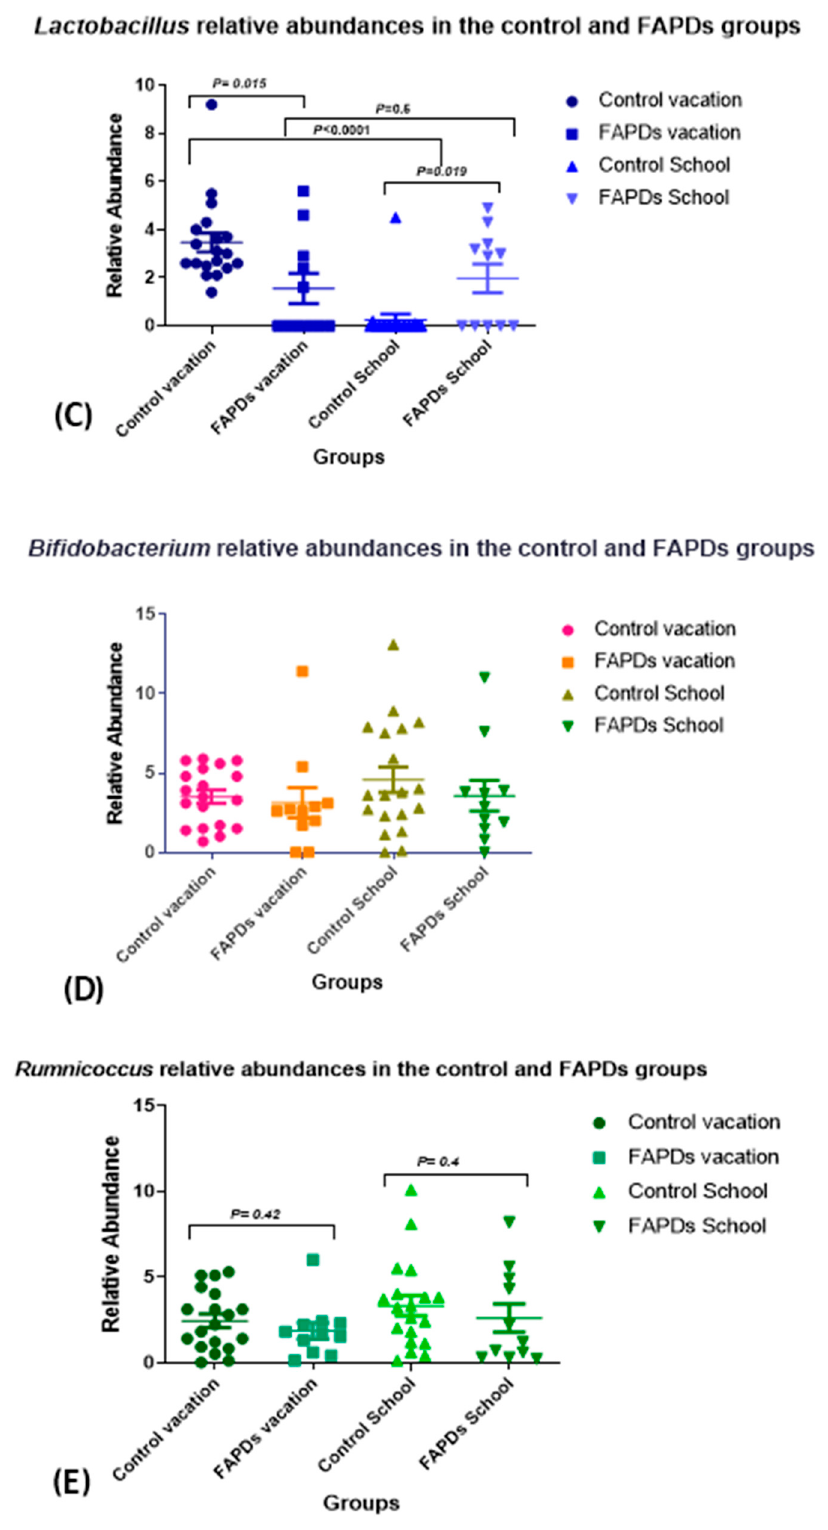
Figure 3. The relative abundance differences of different bacterial species in the control and FAPDs during the school and vacation terms ( p < 0.05 was considered significant). Mann–Whitney U test was used to compare the relative abundances between control and FAPDs groups ( p < 0.05 was considered significant). ( A ) denotes Faecalibacterium relative abundance, ( B ) denotes Bacteroides relative abundance, ( C ) denotes Lactobacillus relative abundance, while ( D , E ) denote Bifidobacterium and Ruminococcus relative abundances,